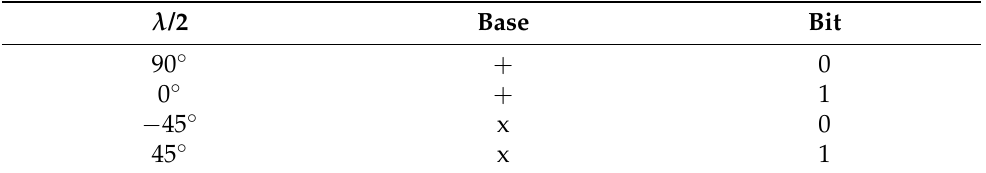
Table 1. Legend for choices between the bit and base to the polarization rotator. λ denotes the wave